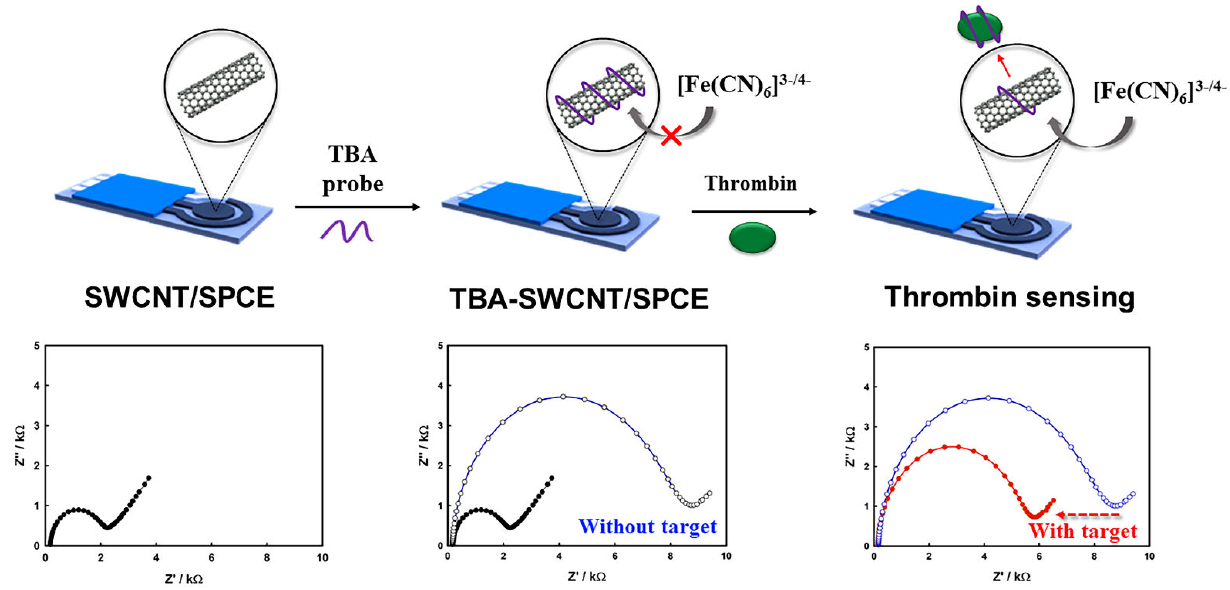
Scheme 1. Schematic illustration of a label − free aptasensor for thrombin detection using a SWCNT casted SPCE. Inset: EIS spectra with (red) and without (blue) target thrombin on TBA − SWCNT/SPCE. Nyquist plot of SWCNT/SPCE (black) was represented.